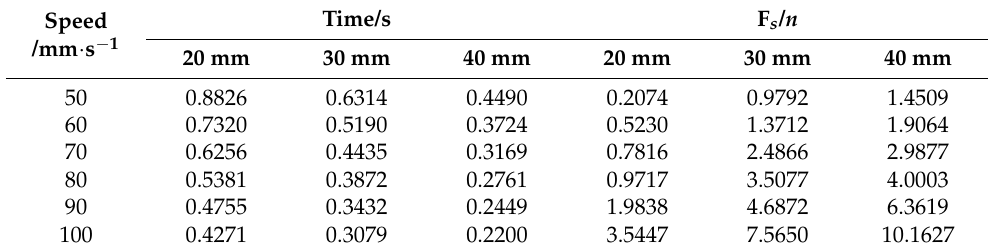
Table 3. Results of motivation